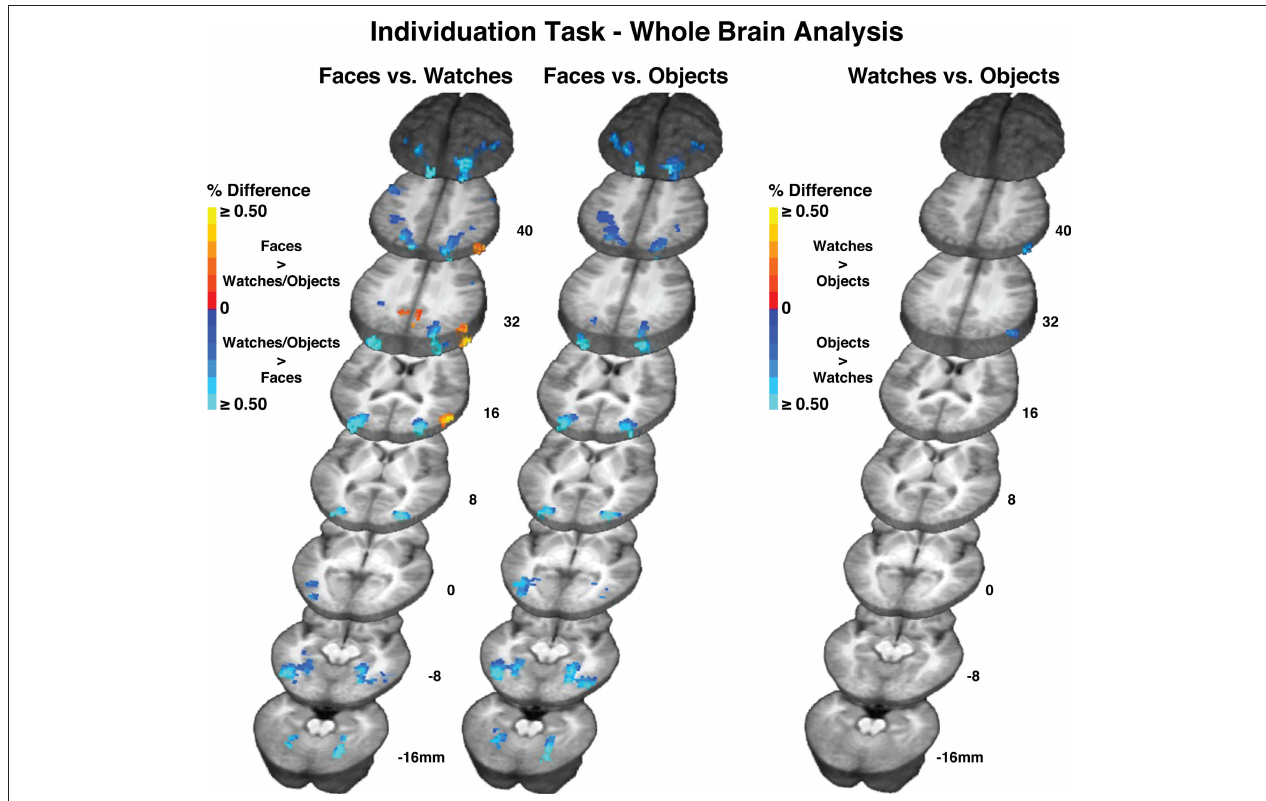
FIguRe S1 | Whole brain activation results for faces and watches in the individuation task. Color bars indicate percent signal change differences. Red to yellow colors indicates regions where faces produced greater activation than watches. Blue colors indicate regions where watches produced greater activation than faces. All activation differences corrected to alpha ≤ 0.05. Activation is shown on averaged structural anatomical scans from all 15